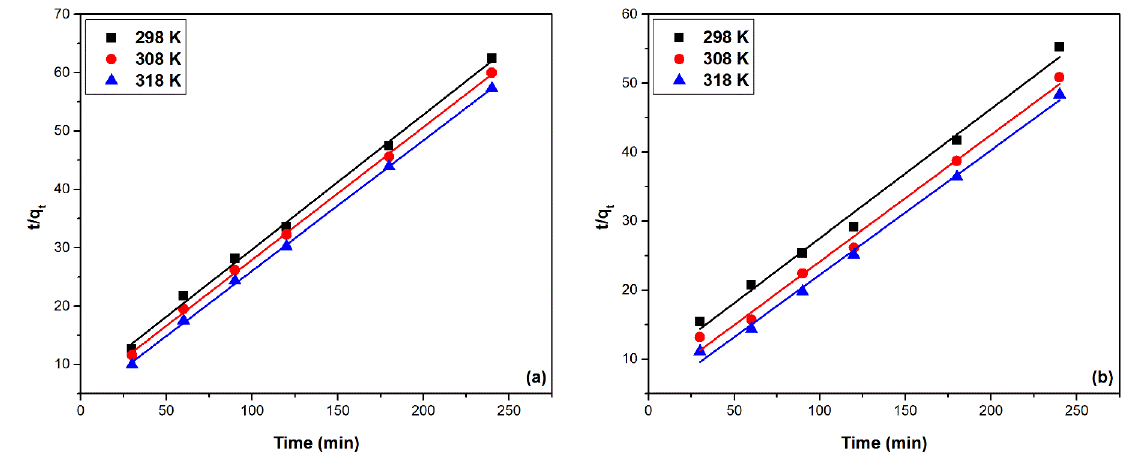
Figure 10. Pseudo-second-order kinetic models: ( a ) MgSiO 3 -DB18C6, ( b ) MgSiO 3 -DB30C10.